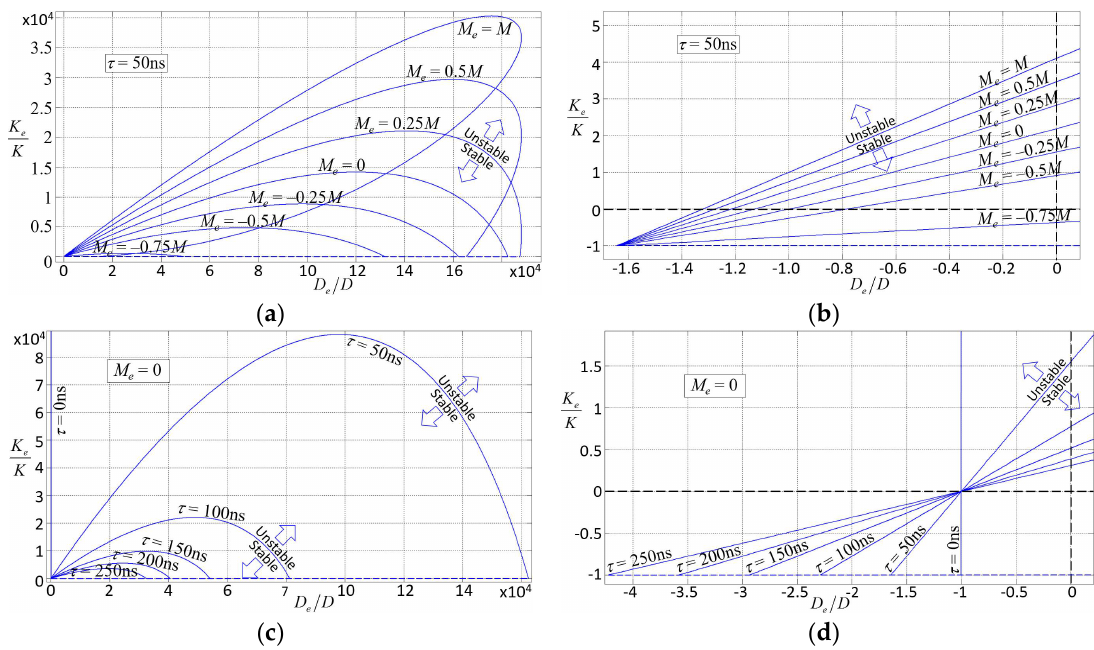
Figure 3. Domains of stability for PODMEMS [29]. The horizontal-axis is the ratio of electrical to mechanical damping. The vertical-axis is the ratio of electrical to mechanical stiffness. The dome areas between the curve and horizontal line K e /K = − 1 are domains of stability. Within a dome, stability decreases the closer the state is to its boundary. Stability is zero on the boundary. And outside a dome, instability increases the farther the state is from its stability boundary. The plot in ( a ) shows stability domains for different values of M e . ( b ) is a magnified view about point ( D e /D , K e /K ) = (0, 0); ( c ) shows stability domains for different values of τ ; and ( d ) shows a magnified view near (0,0). Note, further magnification of ( d ) shows that all curves do not intersect at a single point near (−1, −2.9 × 10 −3 ).